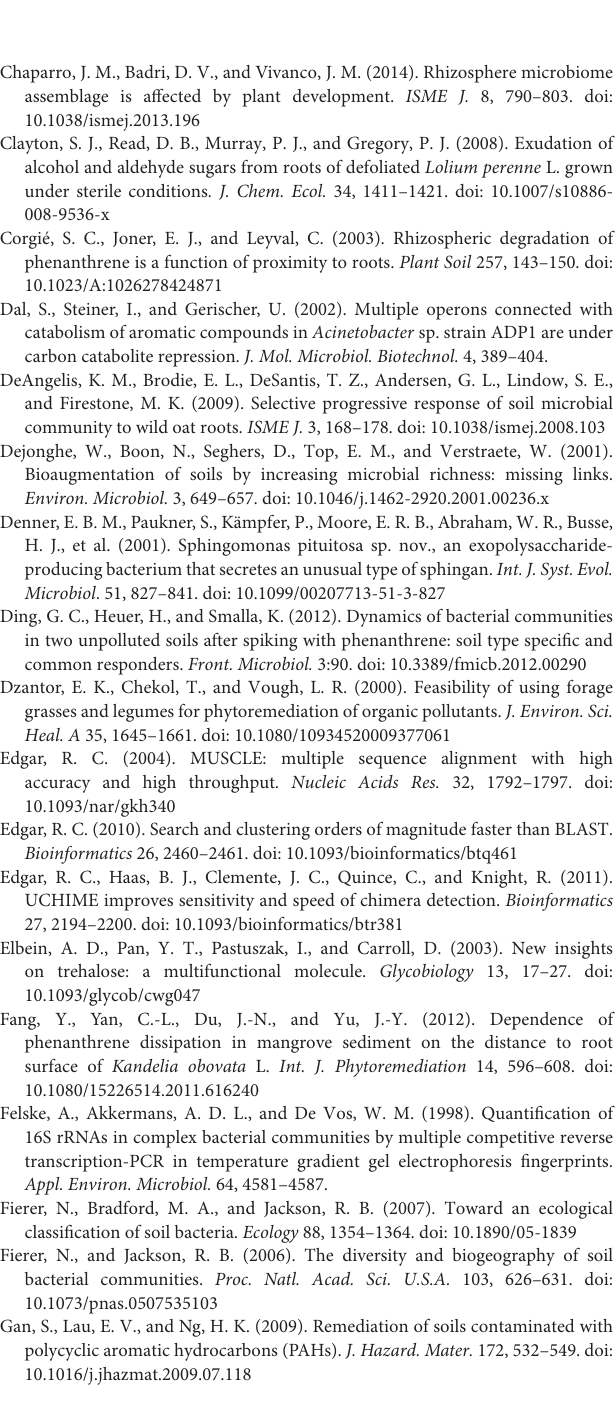
Table S1 | Spearman correlation coefficient between DNA and cDNA read data. Differences between conditions were tested using ANOVA followed by post-hoc Tukey-Kramer test. Letters denote groups with significant differences ( P < 0.05